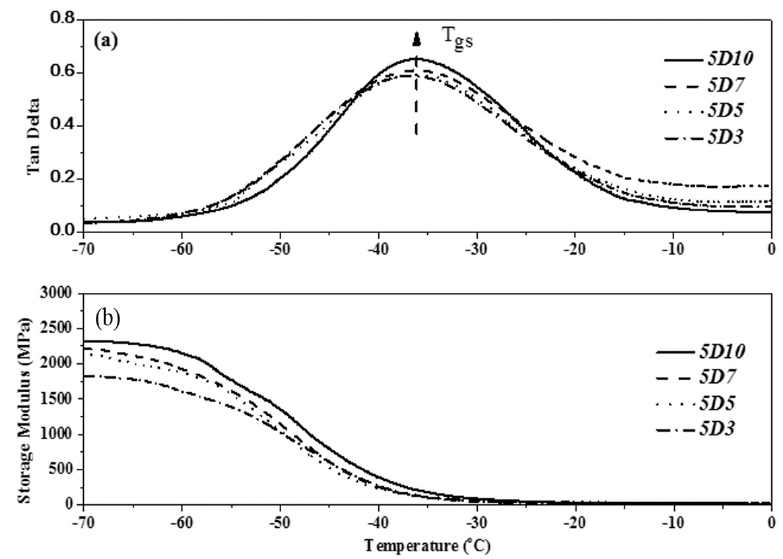
Figure 16. DMA curve of TPU with end-capping agent at concentration of 5.0 phm, (Effect of temperature on ( a ) Tan Delta ( b ) the storage modulus of TPU)